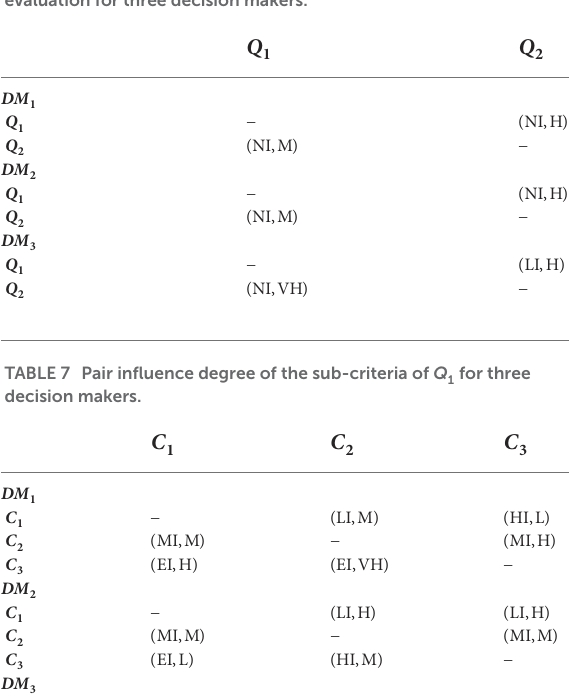
TABLE 6 Pair influence degree between criteria Q 1 and Q 2 of the evaluation for three decision makers.